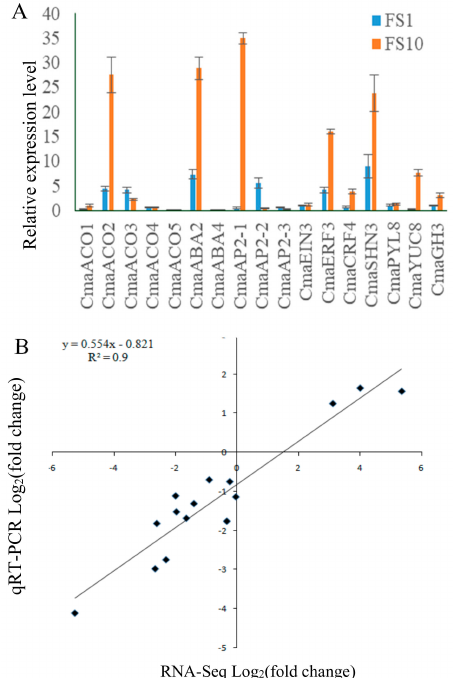
Figure 7. Expression comparison of 17 selected genes using RNA-seq and quantitative reverse transcription polymerase chain reaction (qRT-PCR). ( A ) Relative expression of 17 selected genes in FS1 and FS10 using qRT-PCR. The CmaACO1 expression at FS10 was assumed as 1. Data are displayed as the ratio of expression to CmaActin with three biological replicates. Error bars represent standard error (SE). The qRT-PCR of primers used are given in Table S3. ( B ) Comparison of the expression ratios of 17 selected genes in ‘2013–12’ at LS1 and LS10 stage using RNA-seq and